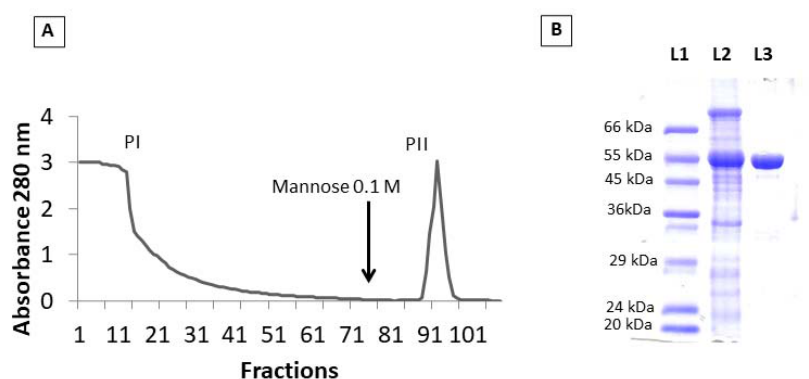
Figure 1. PPL purification. ( A ) Elution profile of PPL in Sephadex G-100 chromatography. ( B ) SDS– PAGE profile, (L1) Molecular mass markers: bovine serum albumin, 66 kDa; glutamic dehydrogenase, 55 kDa; ovalbumin, 45 kDa; glyceraldehyde-3-phosphate dehydrogenase, 36 kDa; carbonic anhydrase, 29 kDa; trypsinogen, 24 kDa and trypsin inhibitor, 20 kDa. (L2) Crude protein extract. (L3) PPL obtained in the PII of the Sephadex